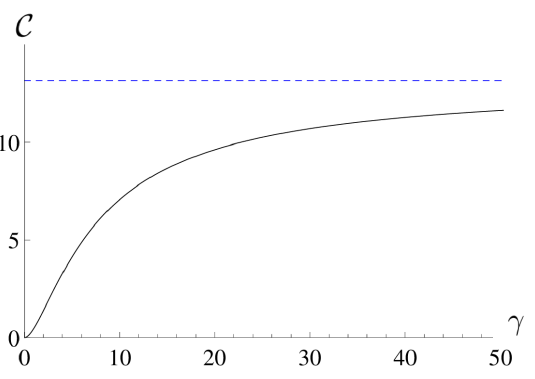
Figure 6: Dimensionless one-body correlation function g TG a function of the dimensionless distance z . Short-distance asymptotics given by Eq. (33) (red, solid) and long-distance asymptotics given by Eq. (32) (black, dashed).